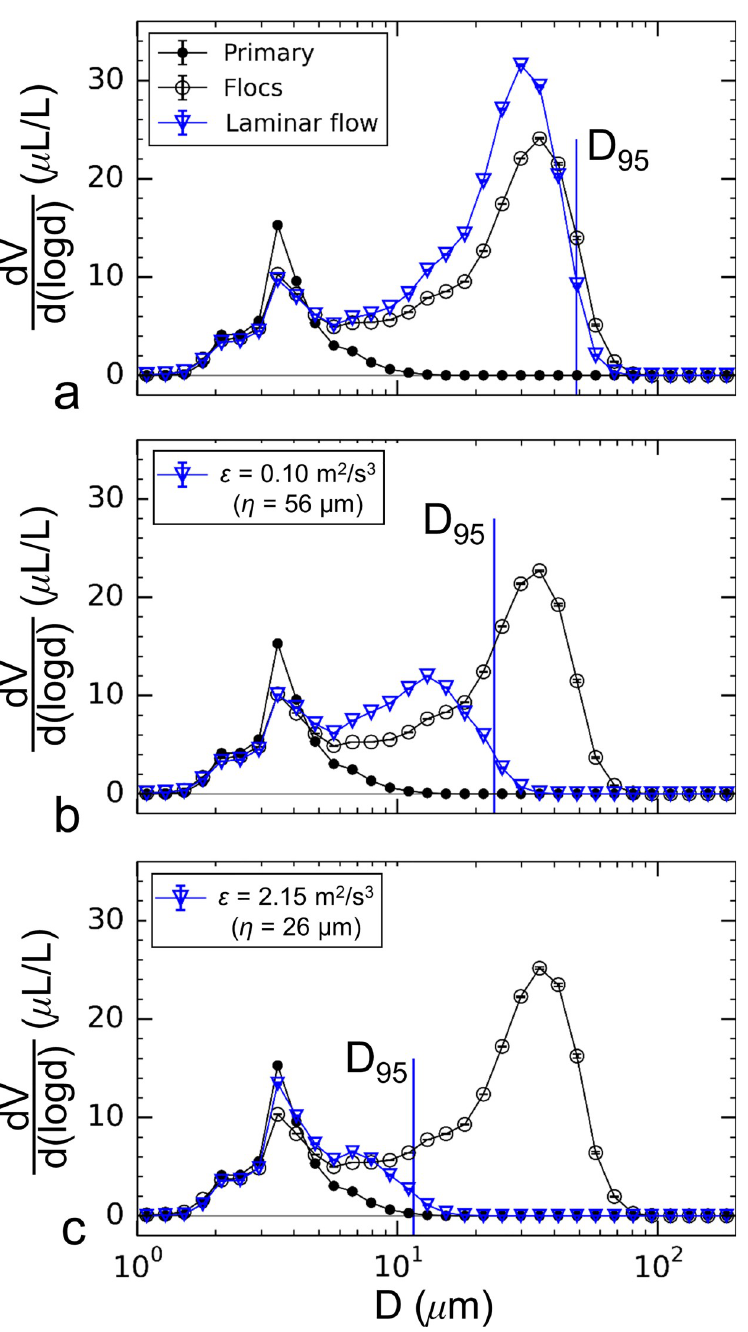
Fig 8. Size spectra of particle volume for the unmixed aggregation tank conditions. Data is plotted for (a) Laminar flow, (b) turbulent flow with ε = 0.10 m 2 /s 3 , and (c) turbulent flow with ε = 2.15 m 2 /s 3 conditions. Spectra for the primary particles, flocs in the aggregation tank, and flocs in the breakup tank are plotted in each